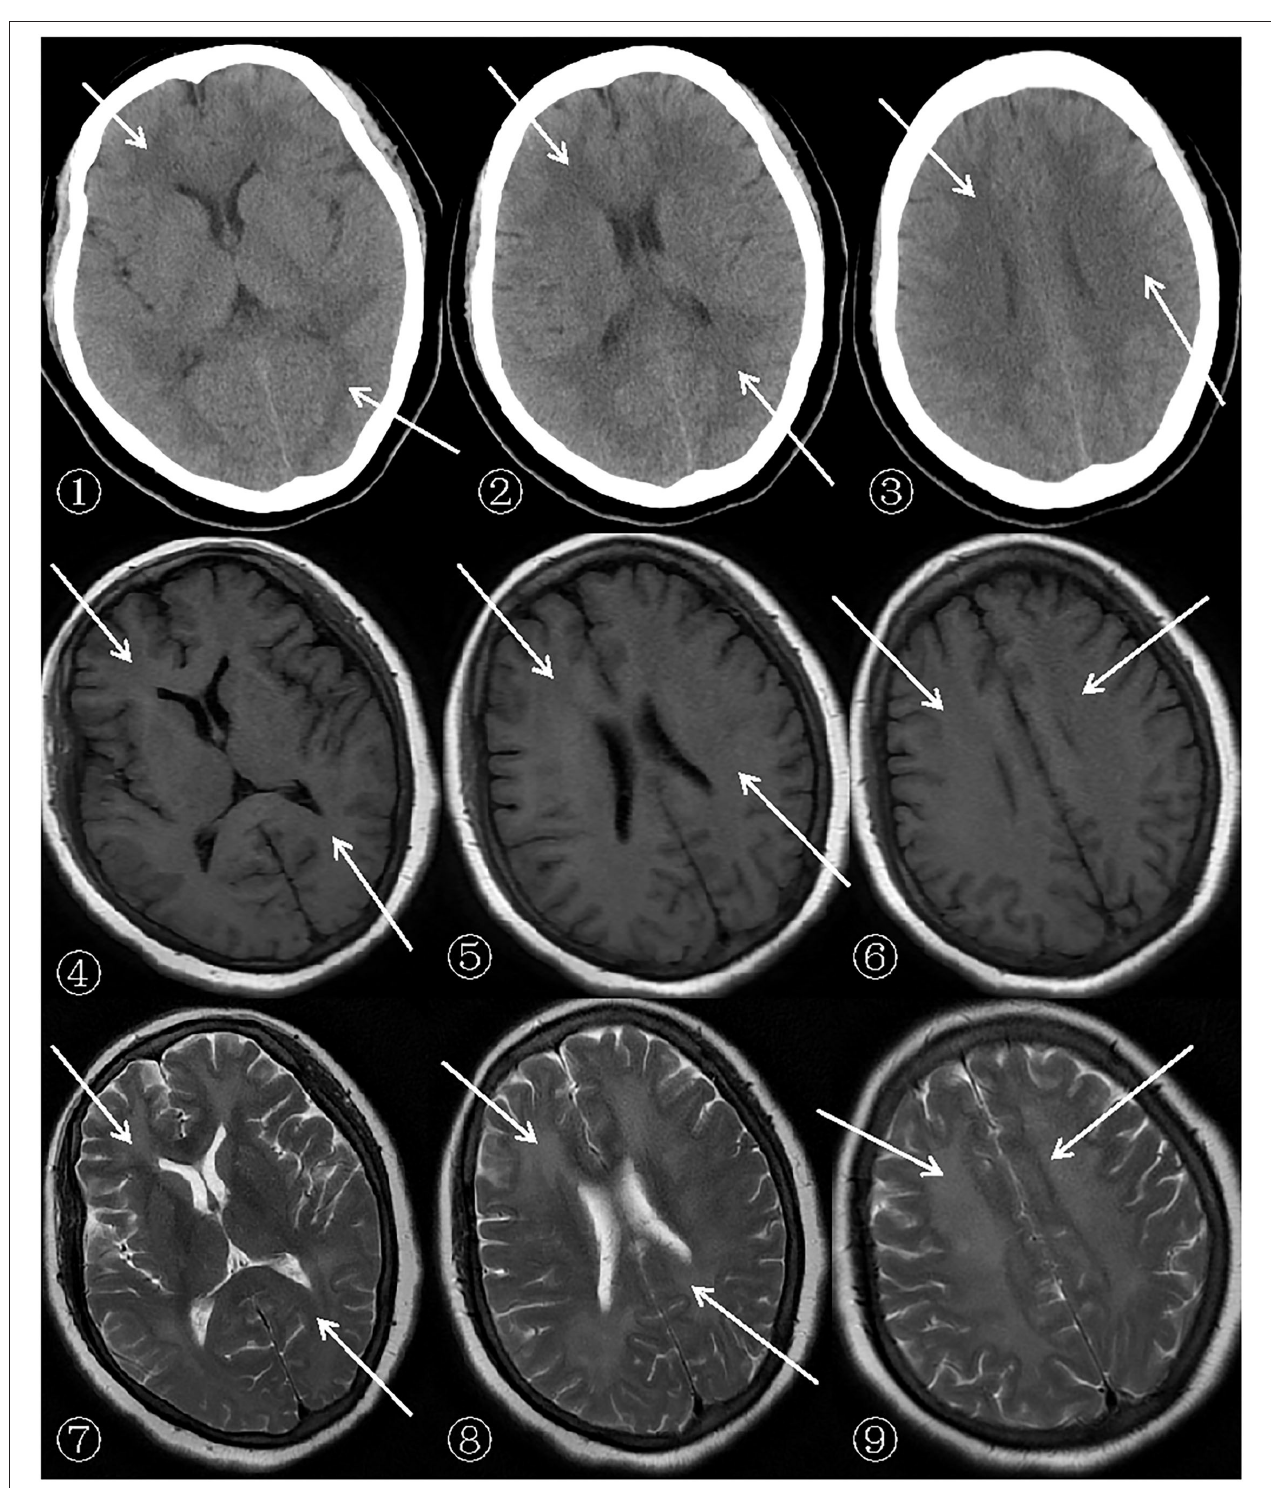
FIGURE 1 | Patient’s cerebral CT (General Electric Company, 64-slice Lightspeed CT) and MRI (SIEMENSAGFWB, skyra 3.0 tesla) scans.